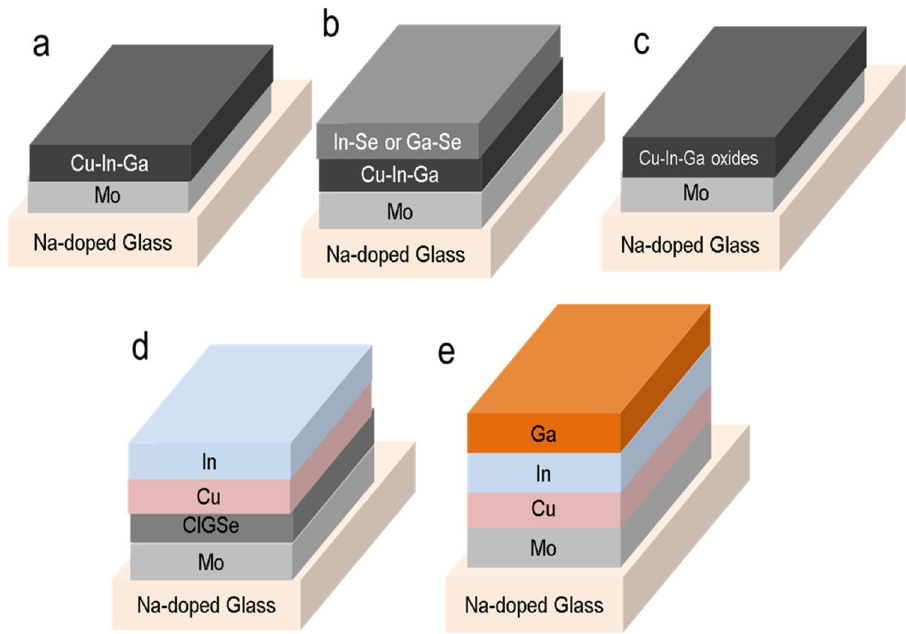
Fig. 12 CIGSe electrodeposi- tion schemes and their power conversion